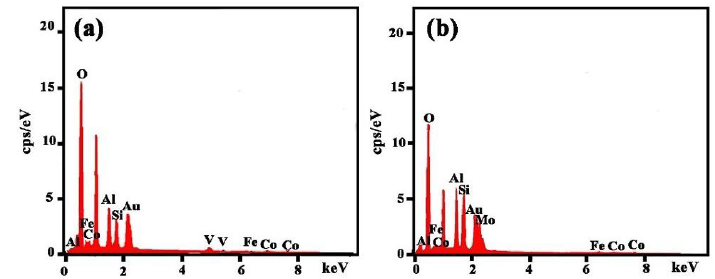
Figure 5. EDS spectra of Fe-Co-V/Zeolite and Fe-Co-Mo/Zeolite